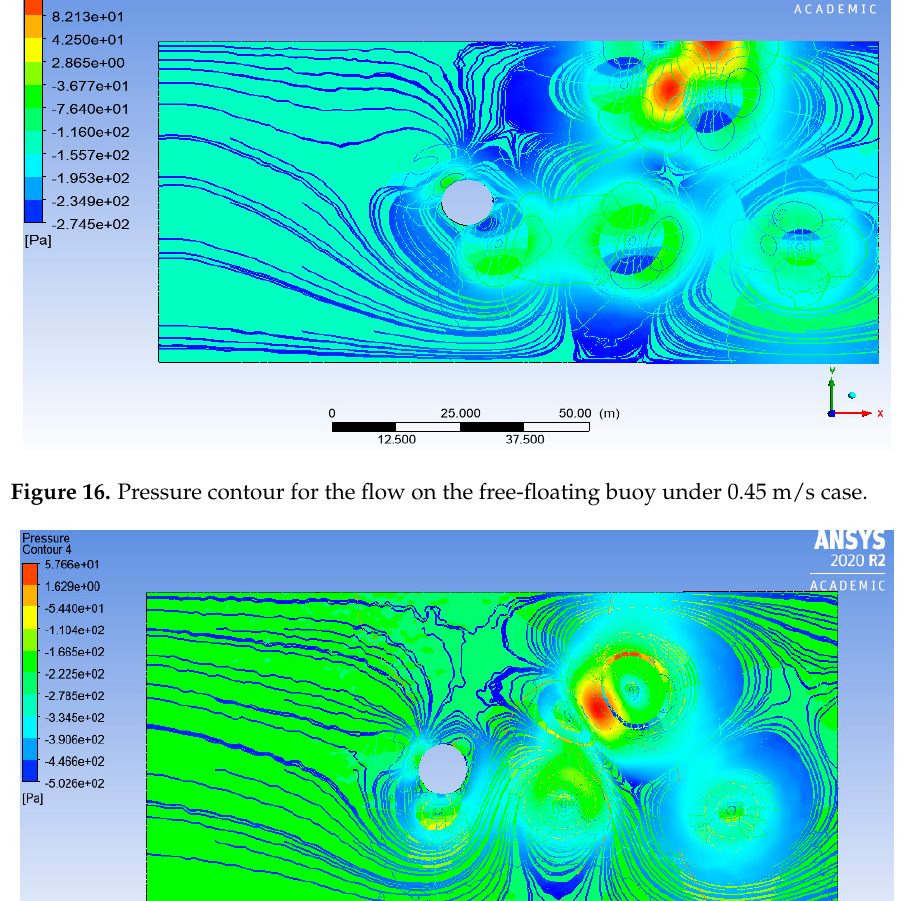
Figure 15. Velocity contour for the flow on the free-floating buoy under 1.5 m/s case.